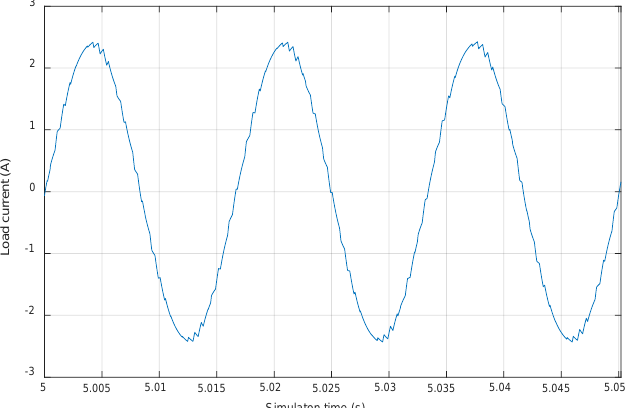
Figure 9. Waveform of the load current.